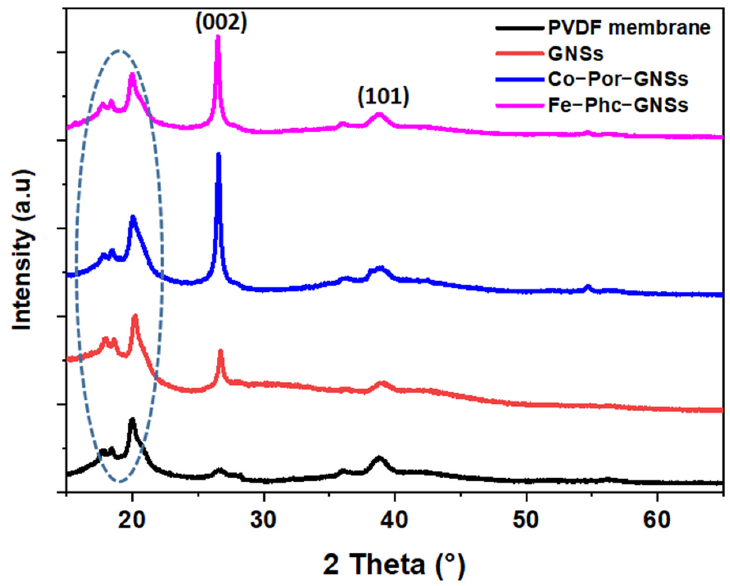
Figure 2. XRD patterns (bottom to top) of GNSs, Co-Por-GNSs, Fe-Phc-GNSs, and PVDF membrane. The marked circle are characteristic of PVDF membrane peaks.